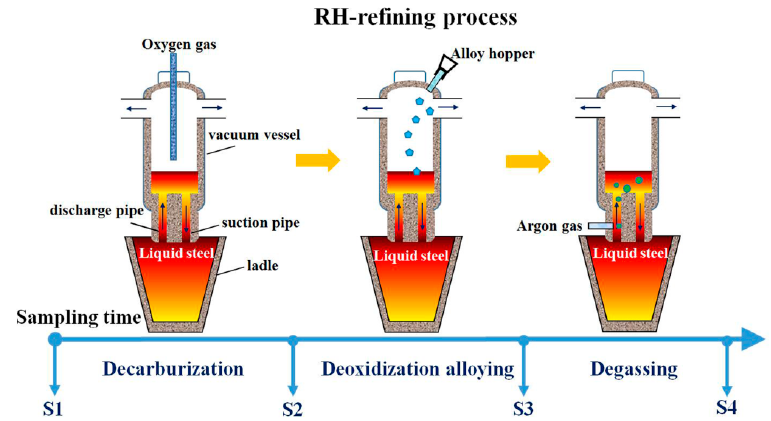
Figure 1. Illustration of sampling during the RH (Ruhrstahl-Heraeus) refining process. Each drawing was cooled down to room temperature and allowed to solidify into a cylindrical ingot. From each ingot, a sample was cut in the form of a thin sheet (50 × 40 × 2 mm 3 ), taken from the ingot.